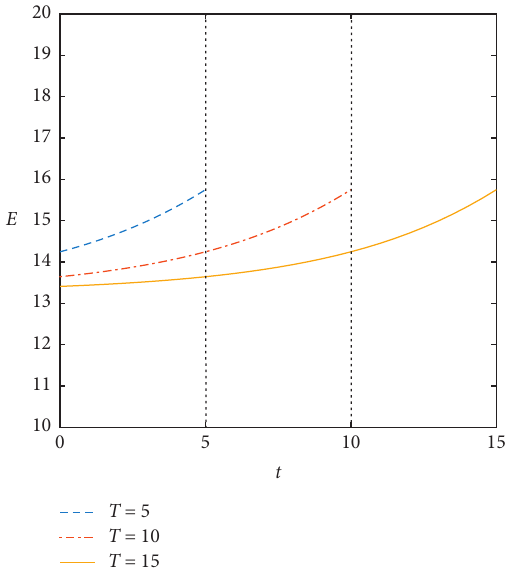
Figure 20: Trajectory curve of optimal instantaneous emission rate under cooperation when the planning period T � 5 ,T � 10, and T �